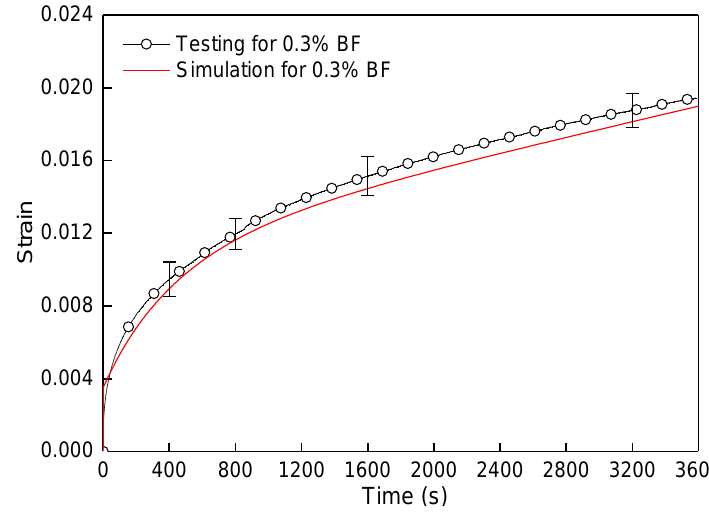
Figure 11. Rheological values of simulation and testing under 0.3% BF content.